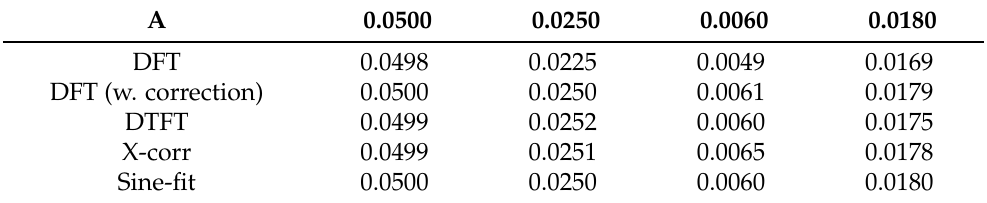
Table 10. Amplitude results returned by AC signal analysis algorithms for the considered test